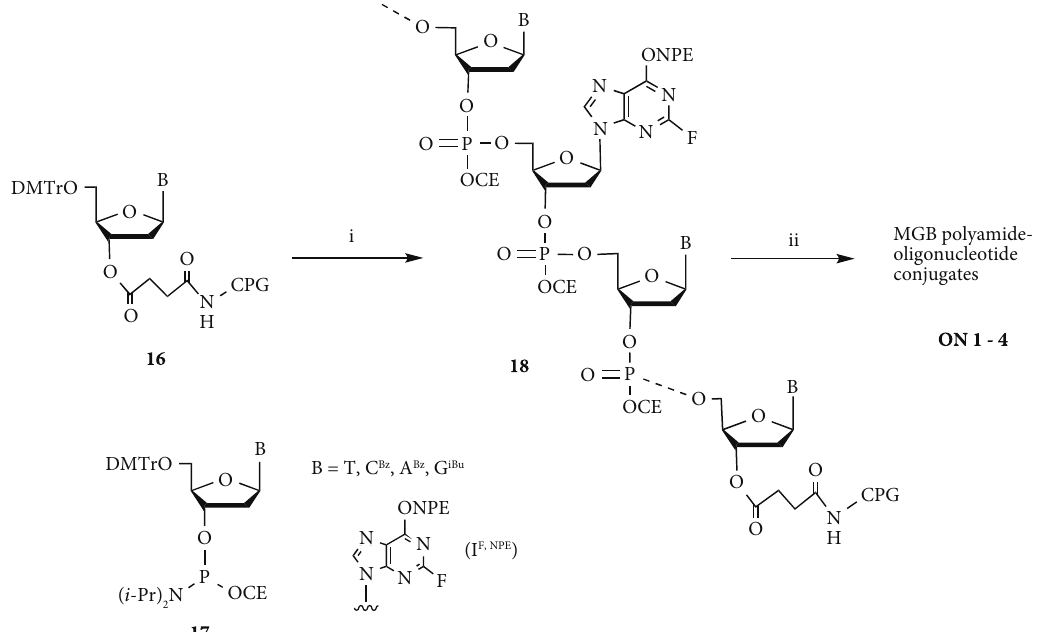
Scheme 4: Synthesis of MGB polyamide-oligonucleotide conjugates. Reagents and conditions: i Oligonucleotide assembly on CPG support by the phosphoramidite method, 3% Cl lutidine, 1-methylimidazole, THF; and 0.02M